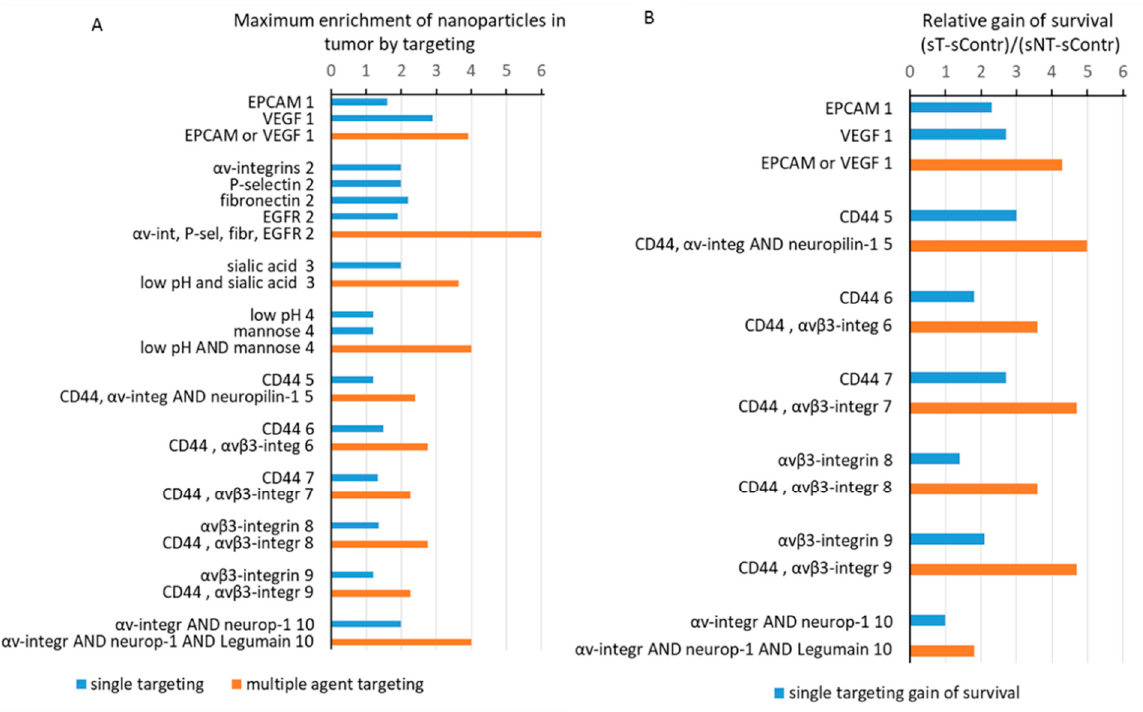
Figure 4. Combinations of targeting ligands result in higher targeting enrichment and better survival after treatment. ( A ) ENT values for single-ligand targeted nanoparticles are in blue, and for combinatorial targeting, they are shown in orange; ( B ) relative gains of survival for single-ligand targeted nanoparticles are in blue and those observed for combinatorial targeting are in orange. An index shown next to the labels facilitates separation of the groups.